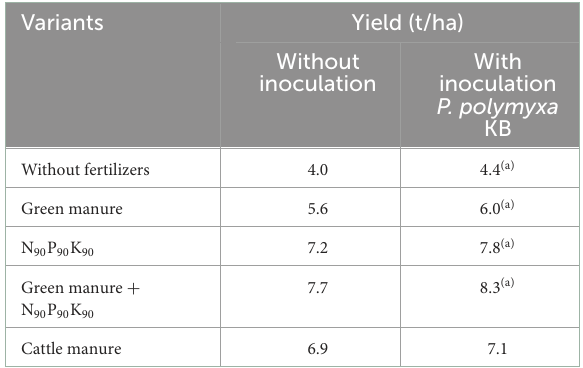
Without inoculation Control, without fertilizers